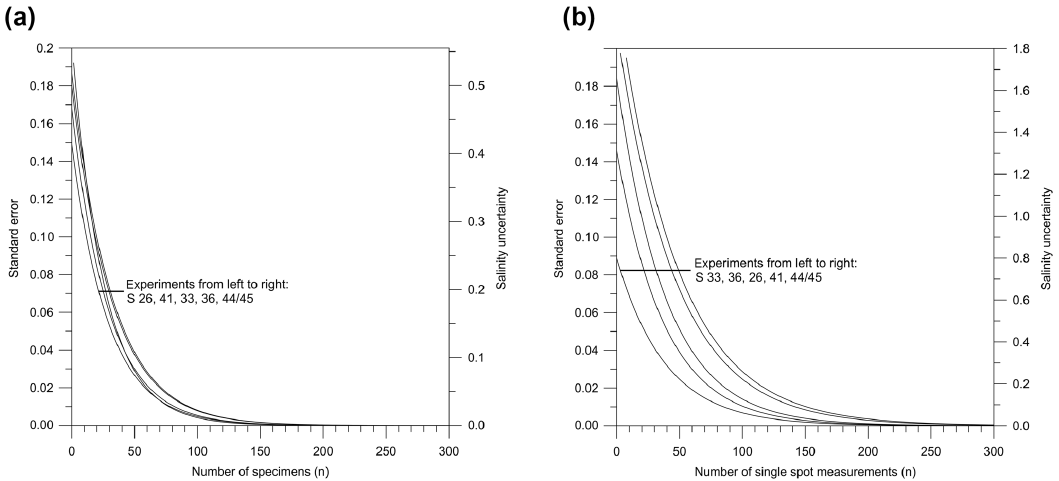
√ n ) of Na / Ca values from cultured T. sacculifer for each salinity experiment ( S ) related Figure C1. Standard errors (standard deviation σ/ to salinity uncertainties. Salinity calculations are based on our calibration (salinity = ( Na / Ca T. sacculifer − 0 . 97 )/ 0 . 115). (a) Number of total specimens needed to resolve a certain salinity range. (b) Number of single spot measurements by electron microprobe analysis within chamber wall cross sections are required to resolve a certain